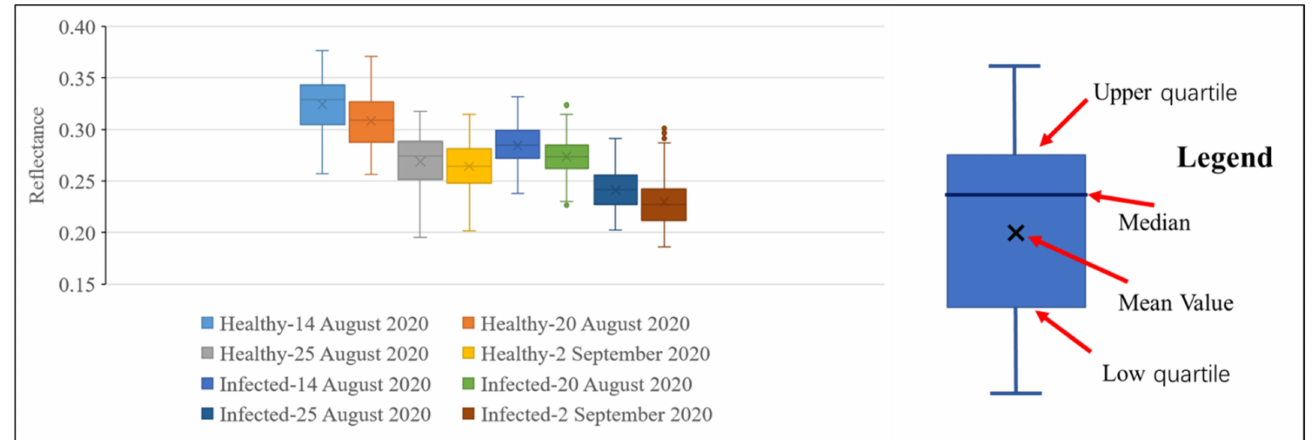
Figure 8. Box diagram of reflectance values of infected and healthy rice at 755 nm on different dates.